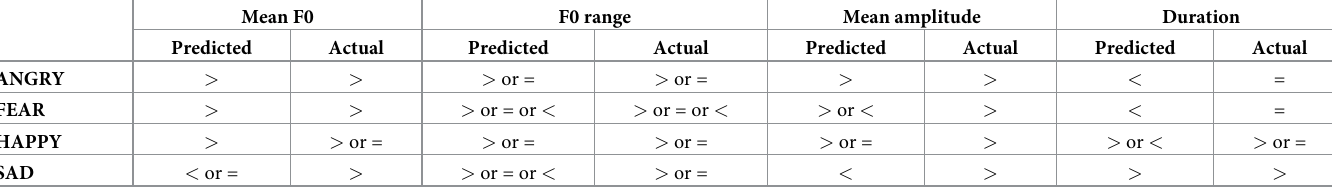
Table 2. Summary of findings from Experiment 1 regarding the effect of emotion relative to the neutral